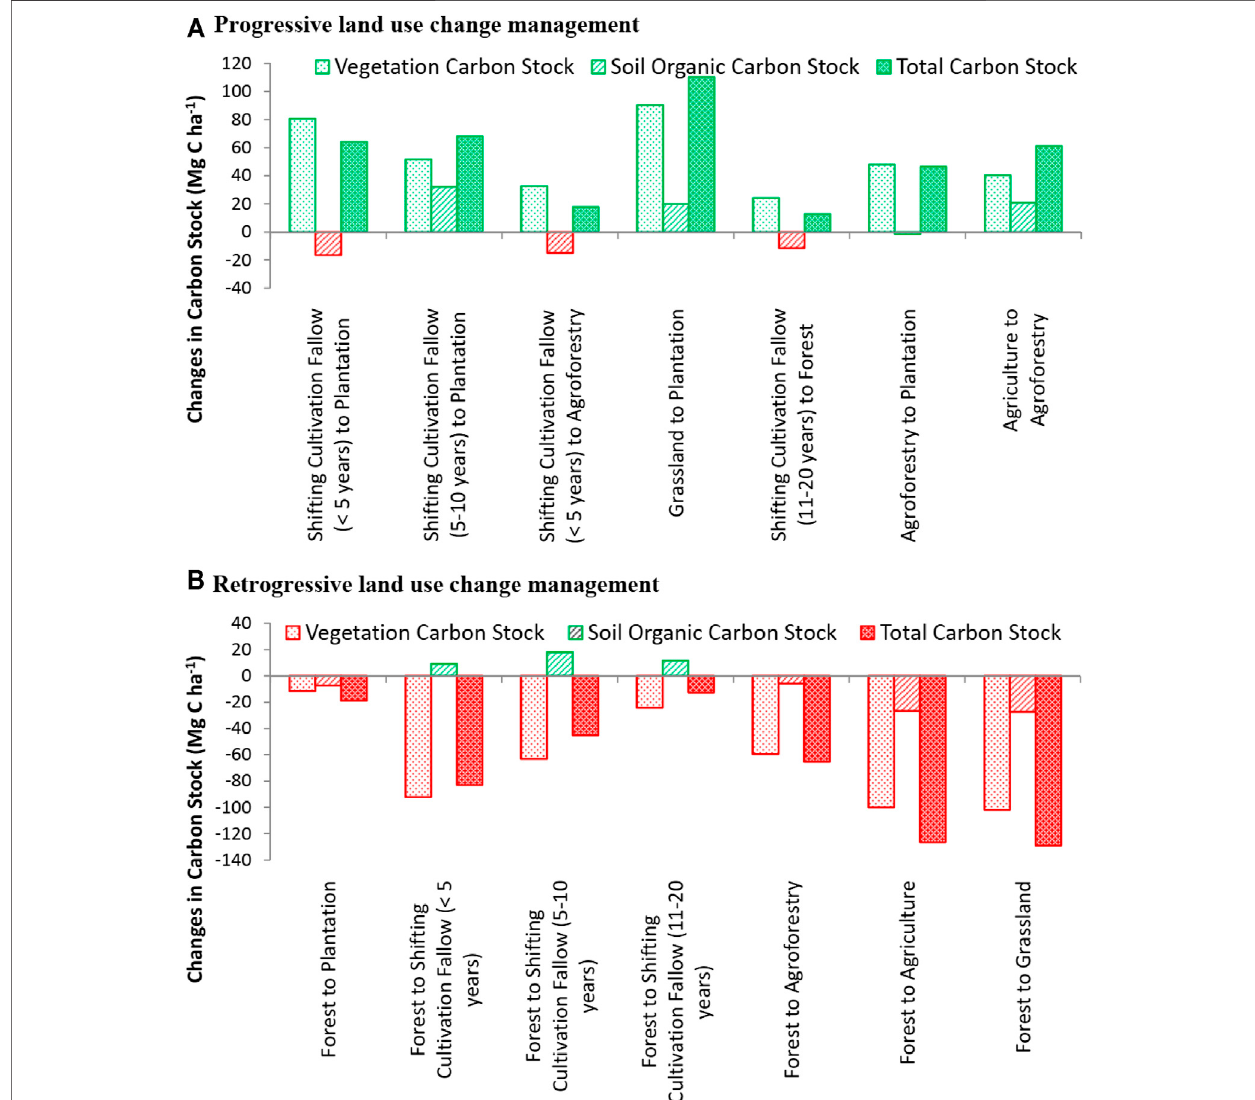
FIGURE3| Changesinsoilorganiccarbonstock(SOCS)(MgC ha − 1 ),vegetationcarbonstock(VCS)(MgC ha − 1 ),andtotalcarbonstock(TCS)(MgC ha − 1 )with respect to (A) progressive and (B) retrogressive land-use change in Northeast India (the values of SOCS refers to 0 – 45 cm soil depth).